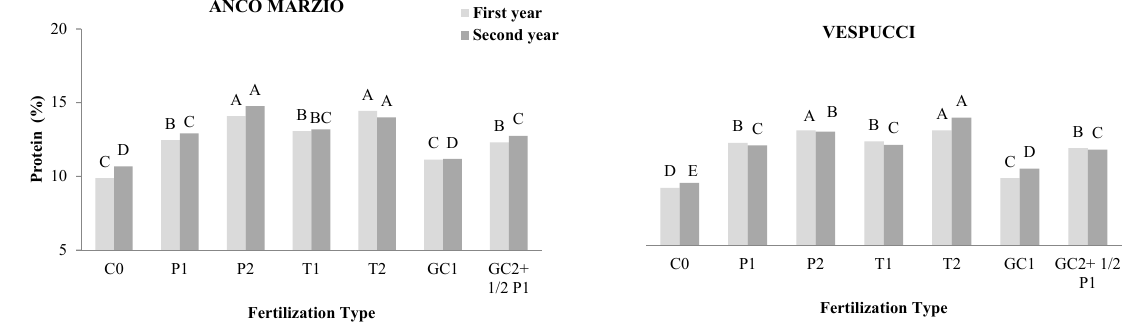
Figure 10. Mean of grain protein content percentage in two durum wheat cultivars (Anco Marzio and Vespucci) grown under different fertilization regime during the first and second year. For each effect considered, the values followed by the same letter are not significantly different, according to the SNK test at p = 0.01.